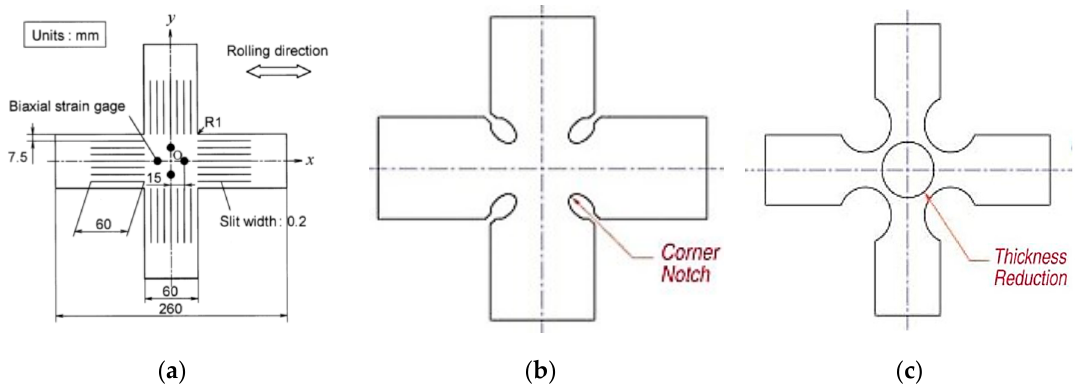
Figure 10. Typical biaxial cruciform specimens with: ( a ) slits [81]; ( b ) elliptical notched corners [70]; ( c ) circular-notched corners and reduced thickness at the centre [70].